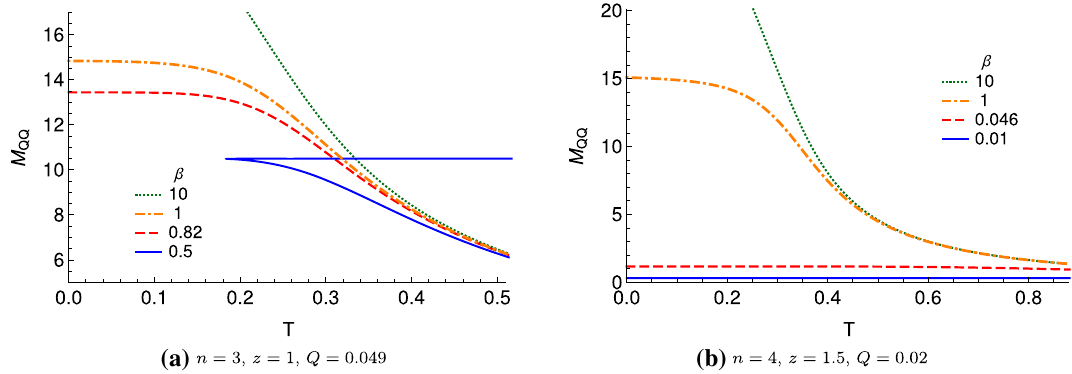
versus T for the Born–Infeld case with l = b = 1 S , Q